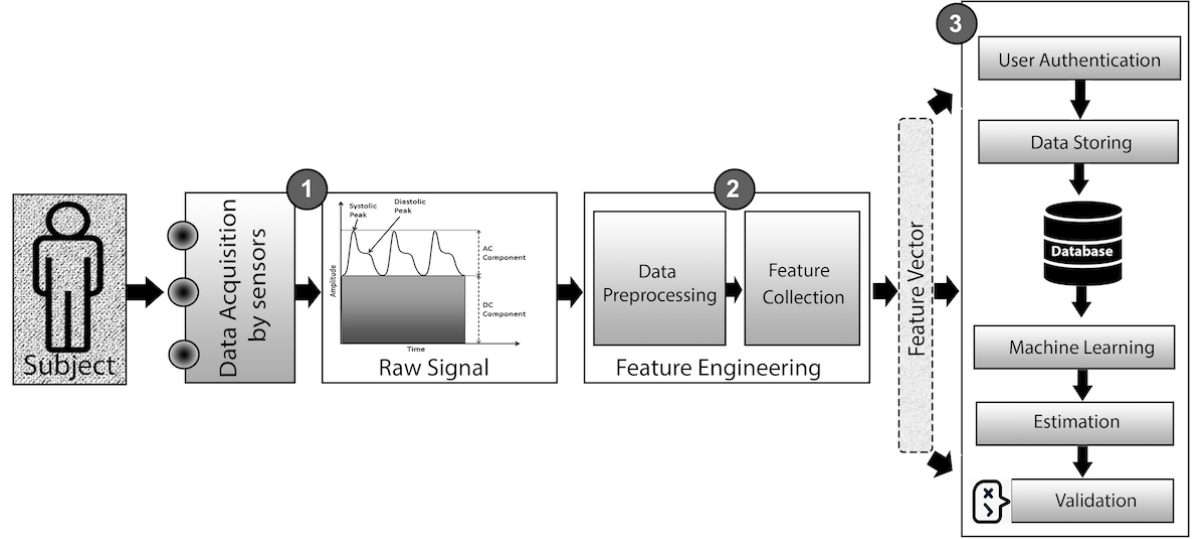
Figure 3. Phases involved in a noninvasive hemoglobin measurement